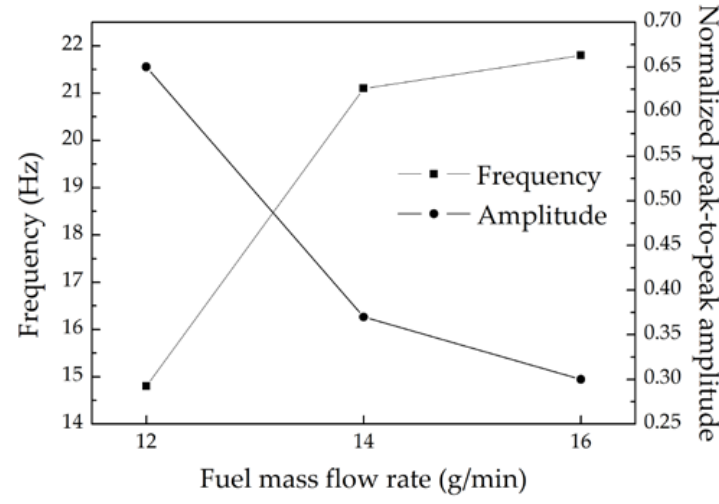
Figure 6. Pulsation frequency and amplitude of flame heat-release rate for fuel mass flow rate.